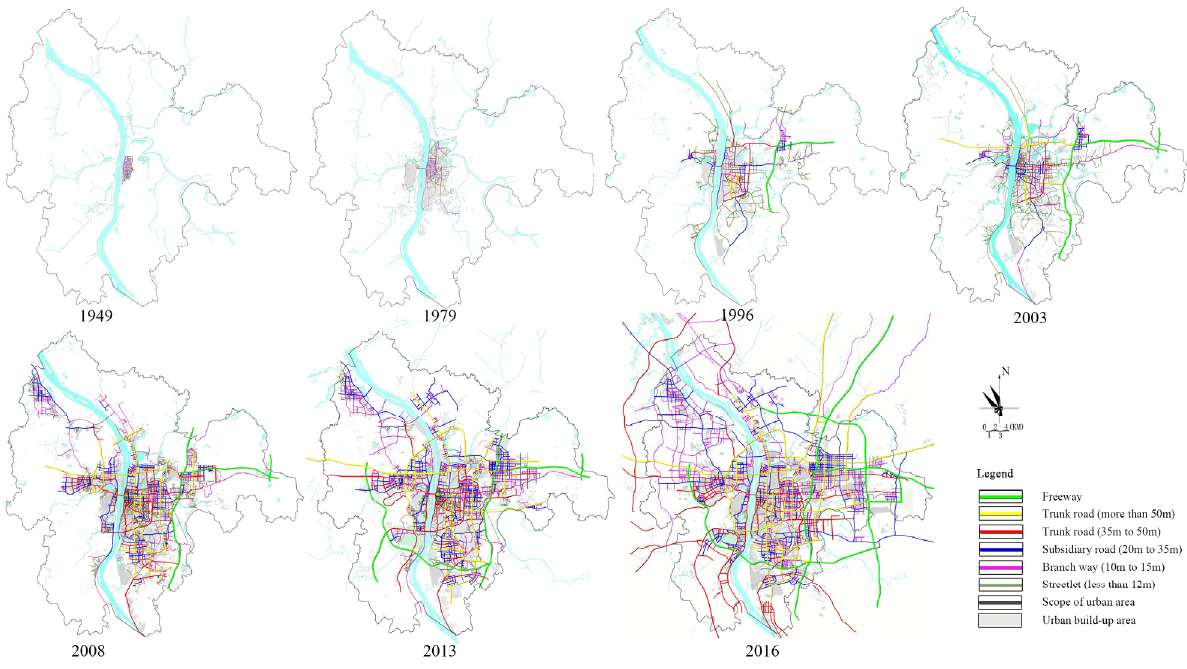
Figure 3. The road network grade division.